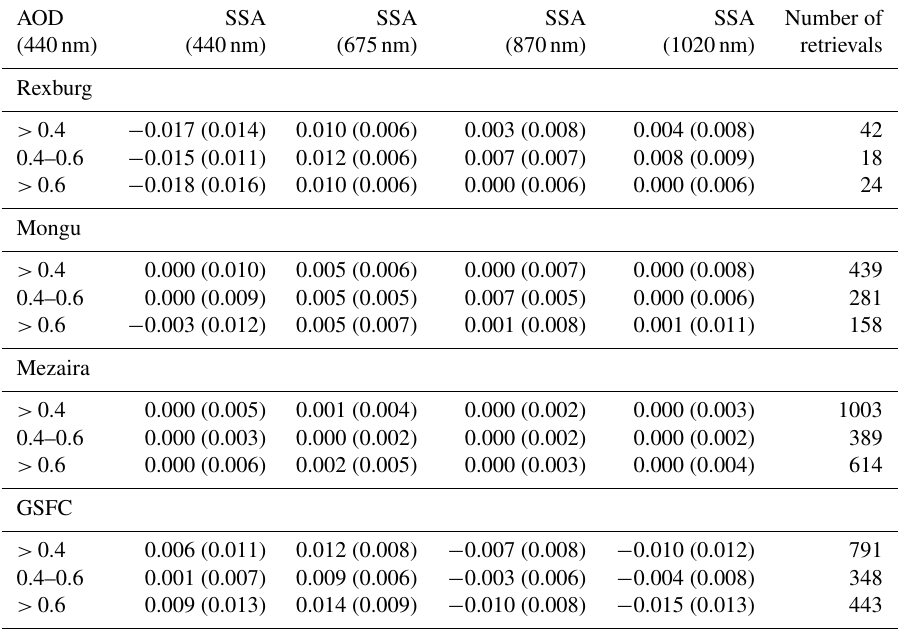
Table 1. Average values and standard deviations (in parentheses) of the difference in SSA retrievals from inversions using STD and REL assumptions on IPRI smoothness constraints. The difference is defined as REL minus STD.